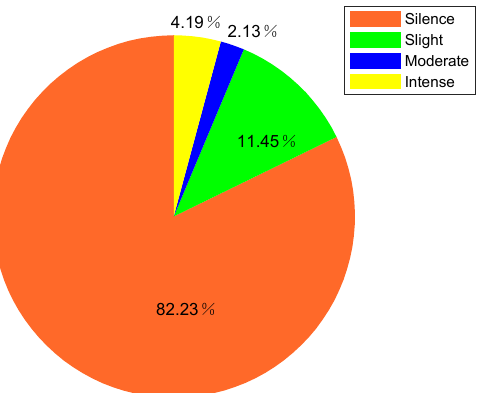
Figure 20. The overall intensity level rate during 24 h of volunteer 1.